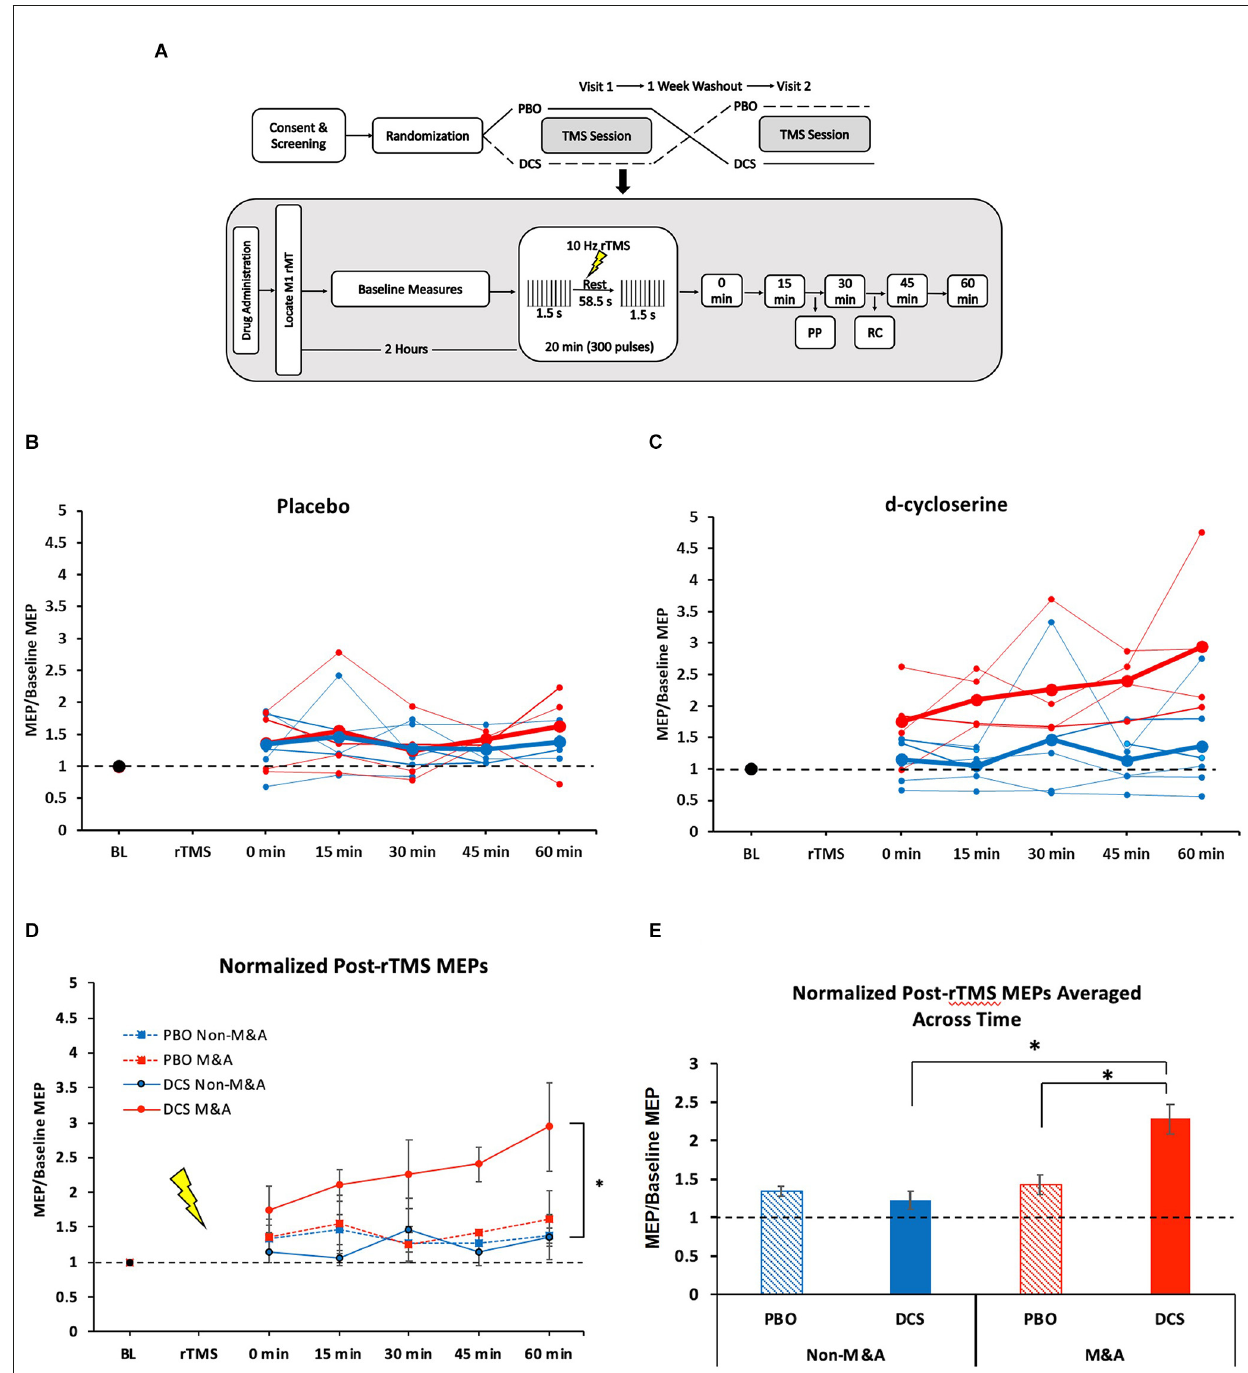
FIGURE1 NMDA receptor partial agonist D-cycloserine (DCS) enhances 10-Hz rTMS-induced motor-evoked potentials (MEPs) exclusively for Musicians and Athletes. (A) Study design. Top: Overview of full experiment. Below: TMS session protocol. Baseline measures include SP, PP, and RC. MT and SP bins were recorded at every 15-min post-rTMS time points. (B) Individual subject MEP values for each time point after 10-Hz rTMS for placebo condition. Blue = Non-M&As, Red = M&As. Group averages are in bold. (C) Individual subject MEP values for each time point after 10-Hz rTMS for d-cycloserine condition. Blue = Non-M&As, Red = M&As. Group averages are in bold. (D) Averaged (normalized to baseline) MEP values with standard error of the mean (error bars) for each time point after 10-Hz rTMS for all conditions: 0 min: Non-M&As (1.15 ± 0.14), M&As (1.75 ± 0.34), H (3) = 3.06, p = 0.383; 15 min: Non-M&As (1.06 ± 0.11), M&As (2.1 ± 0.23), H (3) = 7.69, p = 0.053; 30 min: Non-M&As (1.47 ± 0.45), M&As (2.26 ± 0.49), H (3) = 4.93, p = 0.024; 45 min: Non-M&As (1.14 ± 0.18), M&As (2.4 ± 0.24), H (3) = 9.48, p = 0.024; 60 min: Non-M&As (1.37 ± 0.32), M&As (2.94 ± 0.64), H (3) = 6.70, p = 0.082. (E) Normalized MEP values averaged across time with standard error of the mean (error bars) for all conditions: PBO Non- M&As (1.35 ± 0.07), DCS Non-M&As (1.23 ± 0.12), PBO M&As (1.43 ± 0.12), DCS M&As (2.29 ± 0.019). ∗ p < 0.05. PBO, Placebo; DCS, D-cycloserine; SP, single-pulse; PP, paired-pulse; RC, recruitment curve; rMT, resting motor threshold; rTMS, repetitive Transcranial Magnetic Stimulation; MEPs, motor-evoked potentials; M&As, Musicians and Athletes; ICF, intracortical